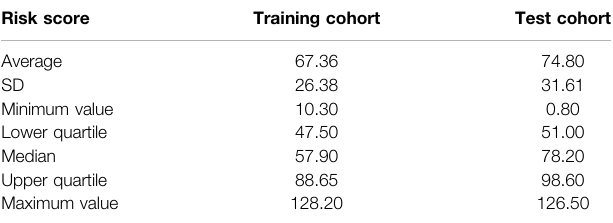
TABLE 6 | Risk score description in training and test